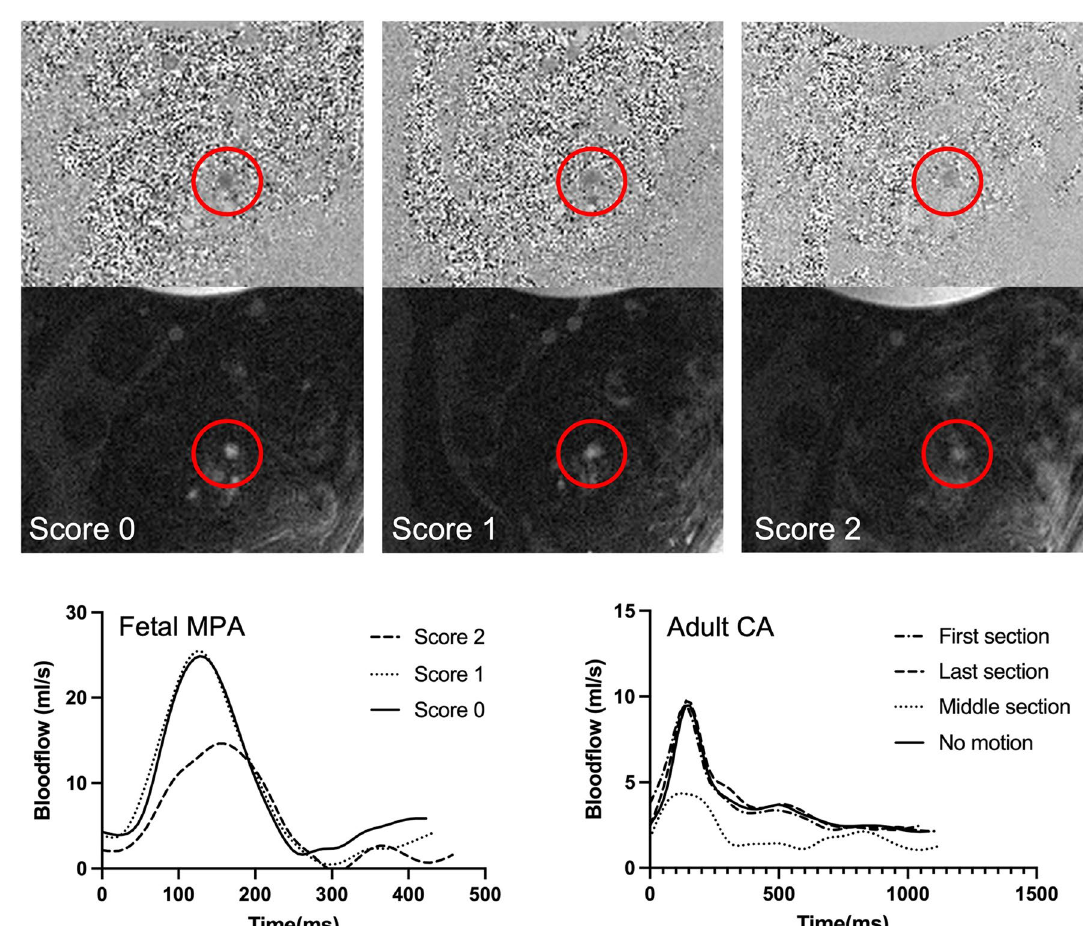
Figure 6. Examples for fetal flow measurements with different scores. Acquisitions of the fetal MPA in the same fetus rated with three different images scores due to different levels of motion corruption. The top row shows the velocity images with the referring magnitude image below. The red circles mark the MPA. The graph at the bottom left shows the flow curves for the acquisitions of the fetal MPA above. On the bottom right, concordant flow curves of measurements in the carotid artery (CA) of an adult during motion corruption in the different sections are